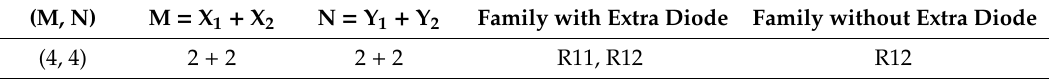
Table 5. Topological families under M = 4 and N = 4.